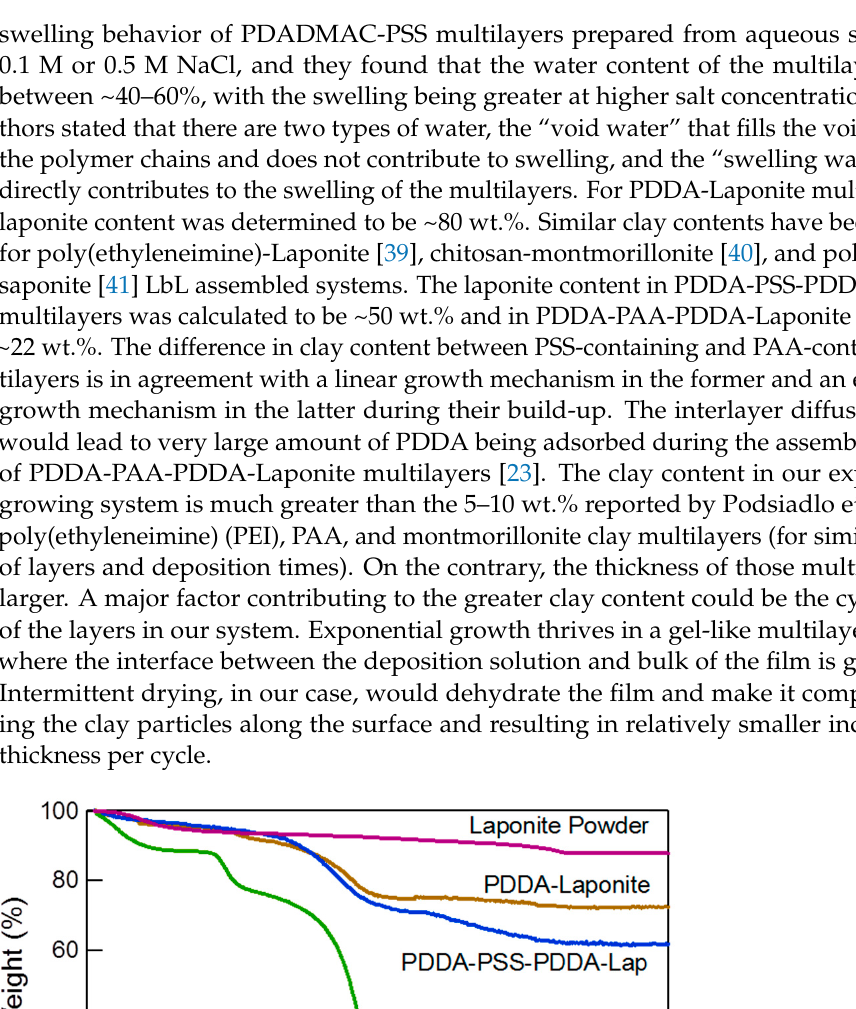
Figure 2. TGA thermograms of laponite powder and multilayers of PDDA-Laponite (360 layers), PDDA-PSS-PDDA-Laponite (180 layers), and PDDA-PAA-PDDA-Laponite (180